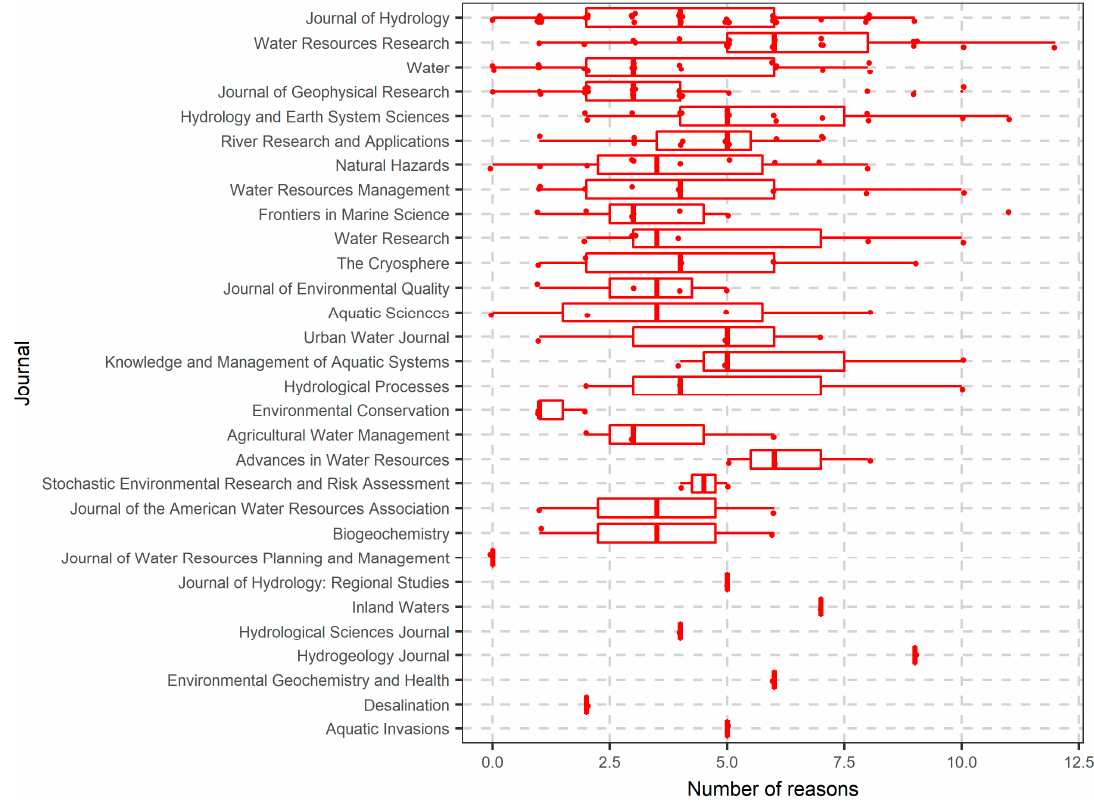
Figure 11. Boxplot of number of reasons per paper for using random forests conditioned on the Journal. The Journals are ranked in descending order based on the number of published papers implementing random forests (see Figure 3).